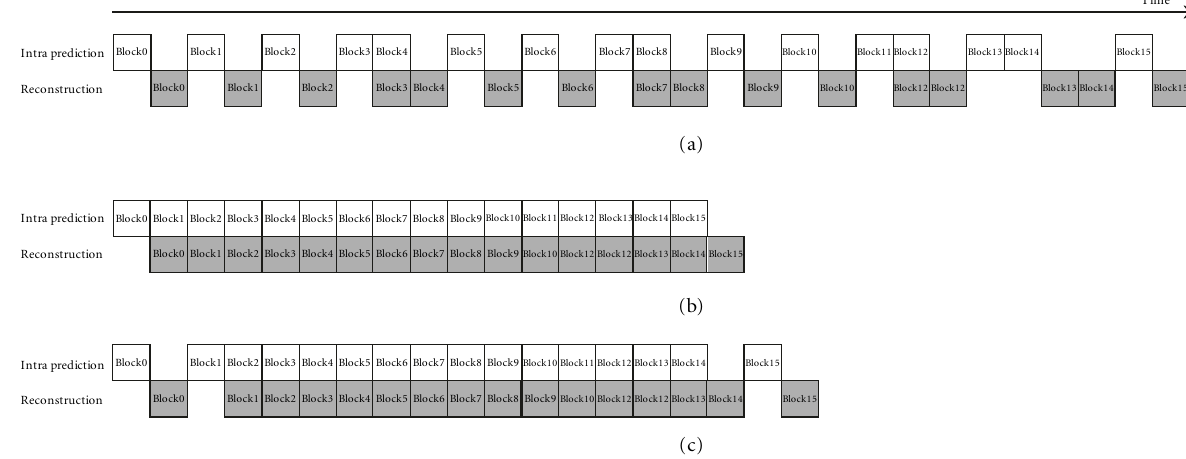
Figure 4: Di ff erence in processing time by pipelined execution of 4 × 4 intra prediction. (a) Partially pipelined execution of 16 4 × 4 blocks in the original processing order. (b) Fully pipelined execution. (c) Partially pipelined execution in the proposed order shown in Figure